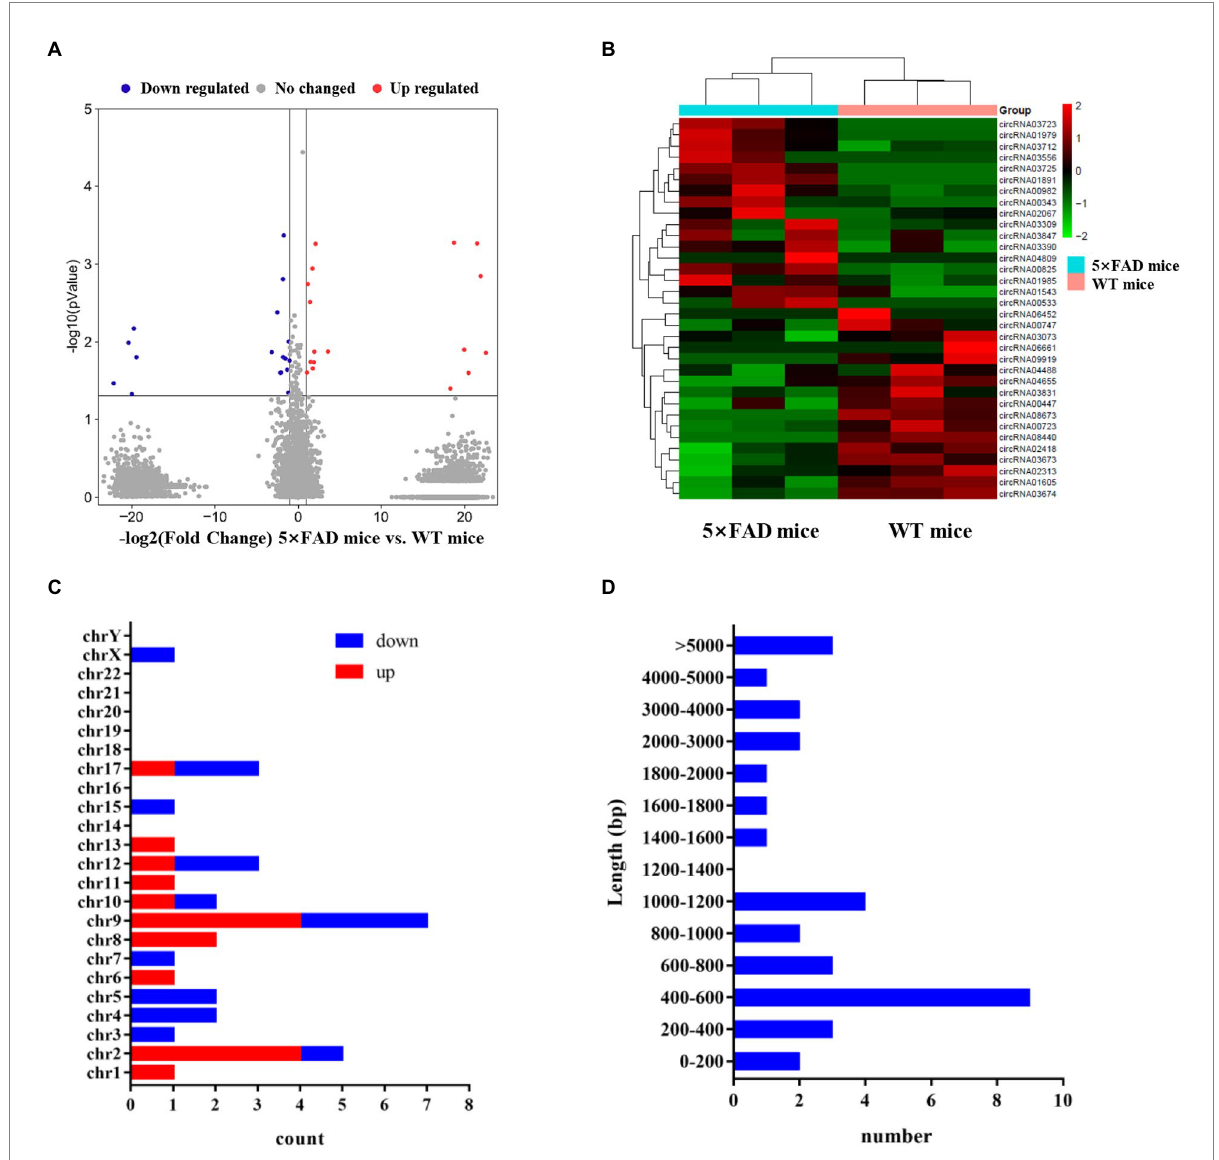
FIGURE 3 Expression profiles of circRNAs in 5 × FAD mice and WT mice. (A) Volcano plot of the circRNAs in the hippocampus of 5 × FAD mice and WT mice. The red dots indicate significantly upregulated circRNAs, the blue dots indicate the significantly downregulated circRNAs, and the gray dots indicate the circRNAs that have no change. (B) Heatmap of the aberrant circRNAs indicating the variation of significantly dysregulated circRNAs in the hippocampus of 5 × FAD mice. (C) Chromosomal locations of the aberrant circRNAs. The X -axis shows the number of circRNAs, and the Y -axis represents the chromosomal number. (D) The sequence length of the aberrant circRNAs. The X -axis indicates the number of circRNAs, and the Y -axis represents the length